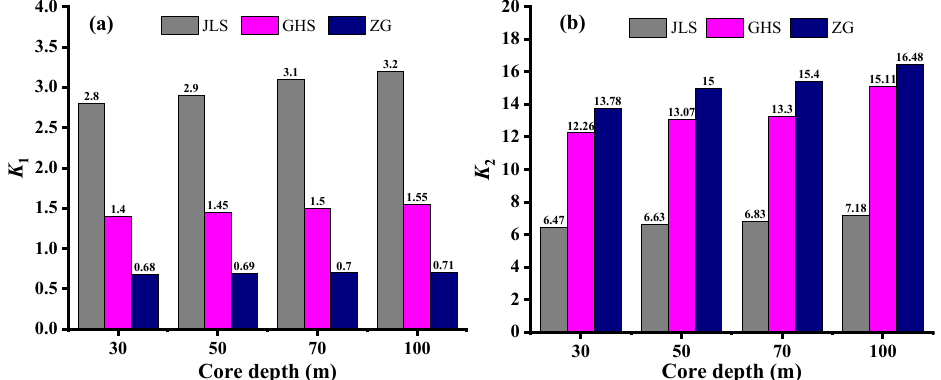
Figure 23. Temperature rising rates in different coal strengths during coring. ( a ): K 1 is the temperature rising rates of first stage during coring; and ( b ): K 2 is the temperature rising rates of second stage during coring.